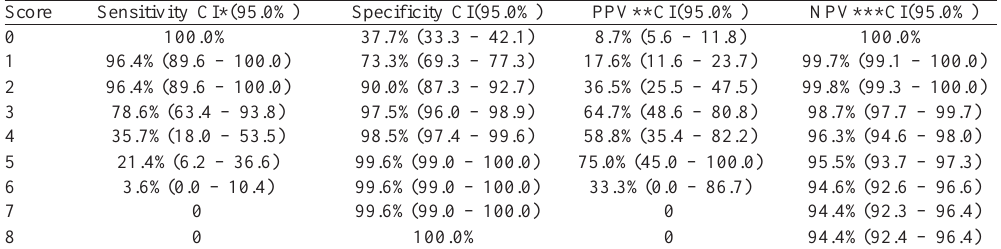
Table 5. Evaluation of MagedanzSCORE in identifying the diagnosis of mediastinitis according to different levels of cut-off.